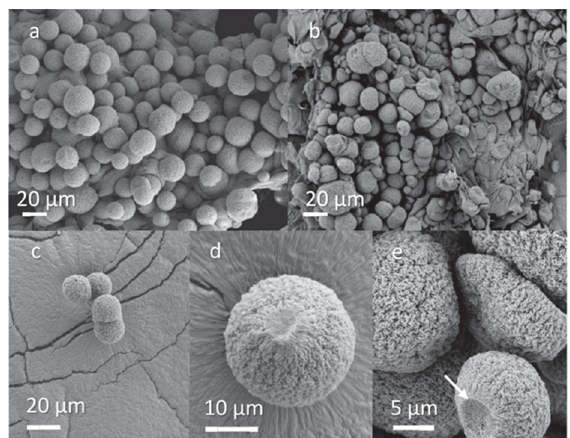
Figure 17. Scanning electron microscopy (SEM) images of microgel particles printed via IJP of aqueous alginate solutions into baths of CaCl 2 with ( a , c , d , and e ) direct or ( b ) sequential solvent exchange. Reproduced from [200] with permission, copyright Elsevier B.V., 2018.